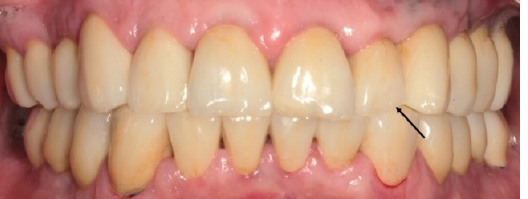
Figure 4. The arrow shows a chip-off of feldspathic porcelain in the incisal edge of a veneered monolithic zirconia restoration that needs only polishing .